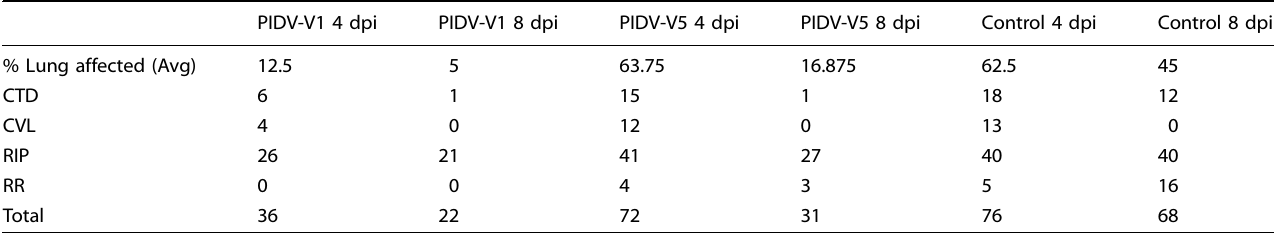
Table 1. Histopathology scores of hamster